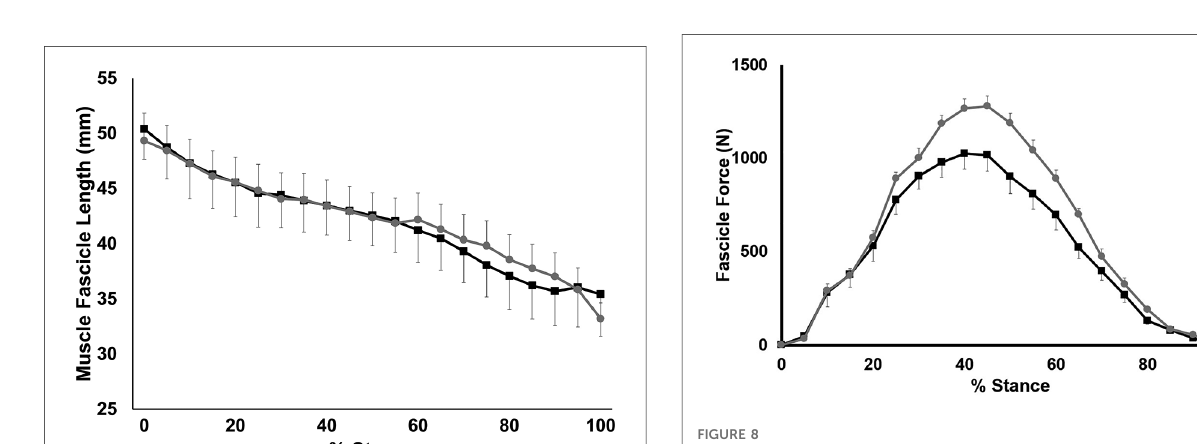
FIGURE 5 The relationship between total AT energy storage and AT MA . Grey circles represent the SHORT AT MA group, while black squares represent the LONG AT MA group. No relationship between AT MA and total AT energy storage was found.